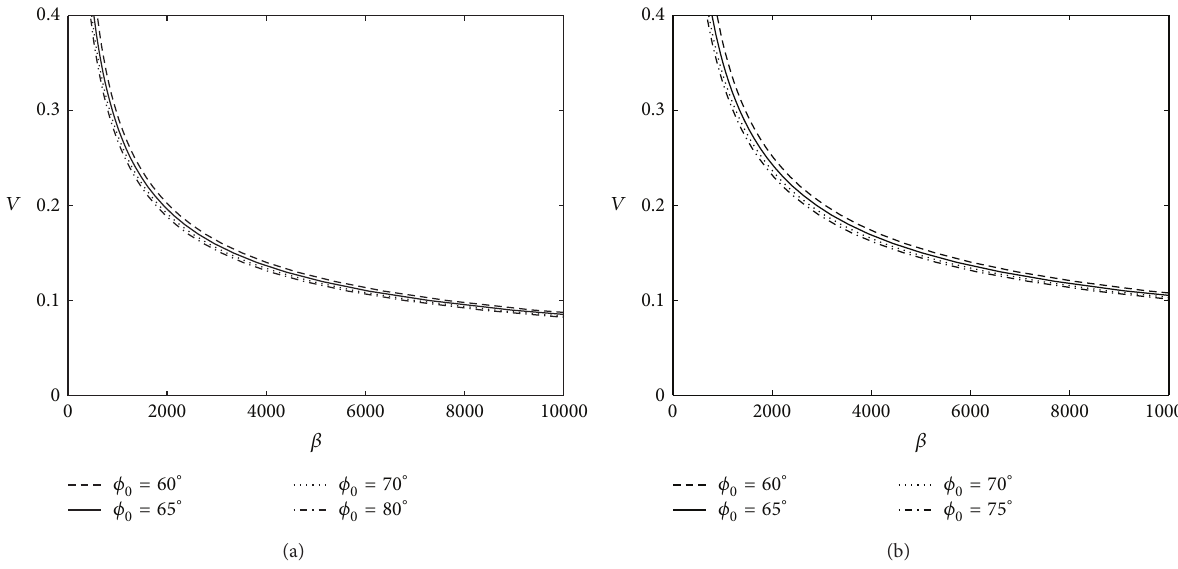
Figure 3: Dropping damage boundary curves of the system when the suspension angle 𝜙 0 = 60 ∘ , 65 ∘ , 70 ∘ , and 75 ∘ and the product fragility (a) 𝐴 𝑐 = 10 and (b) 𝐴 𝑐 = 15 . 𝑉 : the dimensionless dropping shock velocity; 𝛽 : the system parameter.